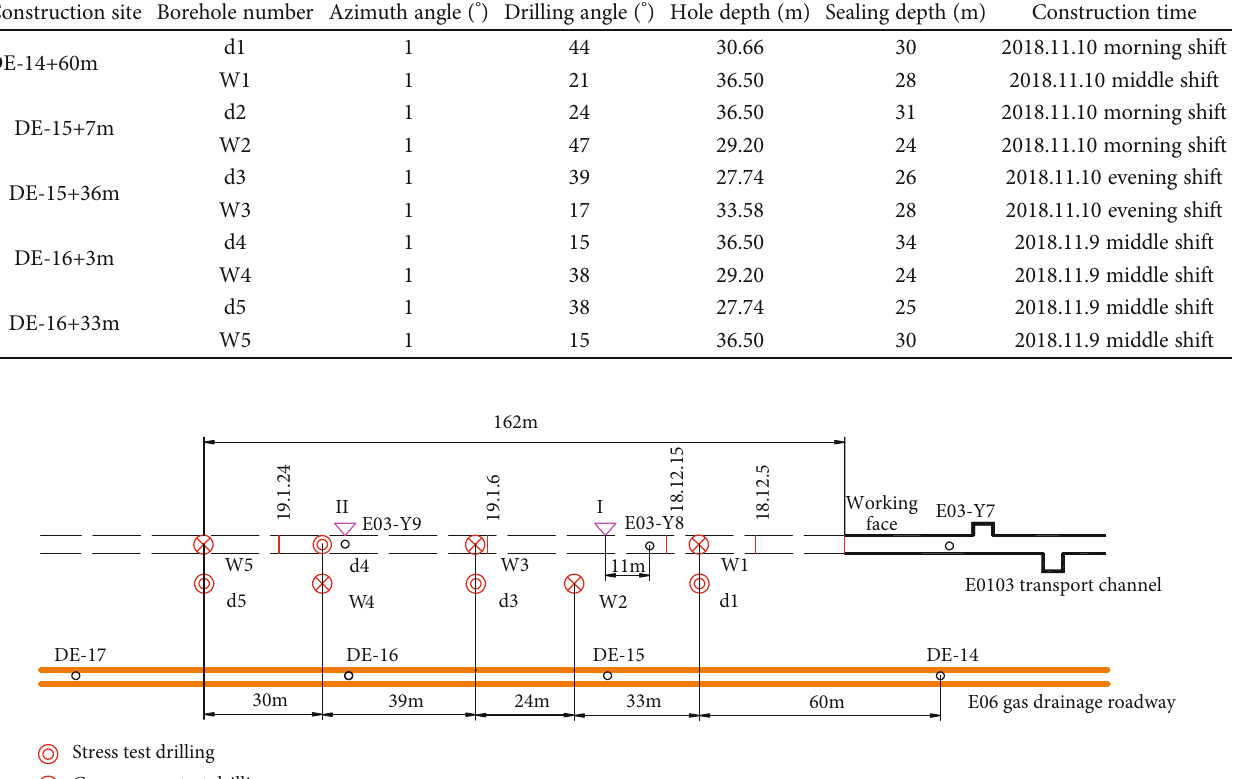
Table 3: Monitoring drilling borehole construction parameters.